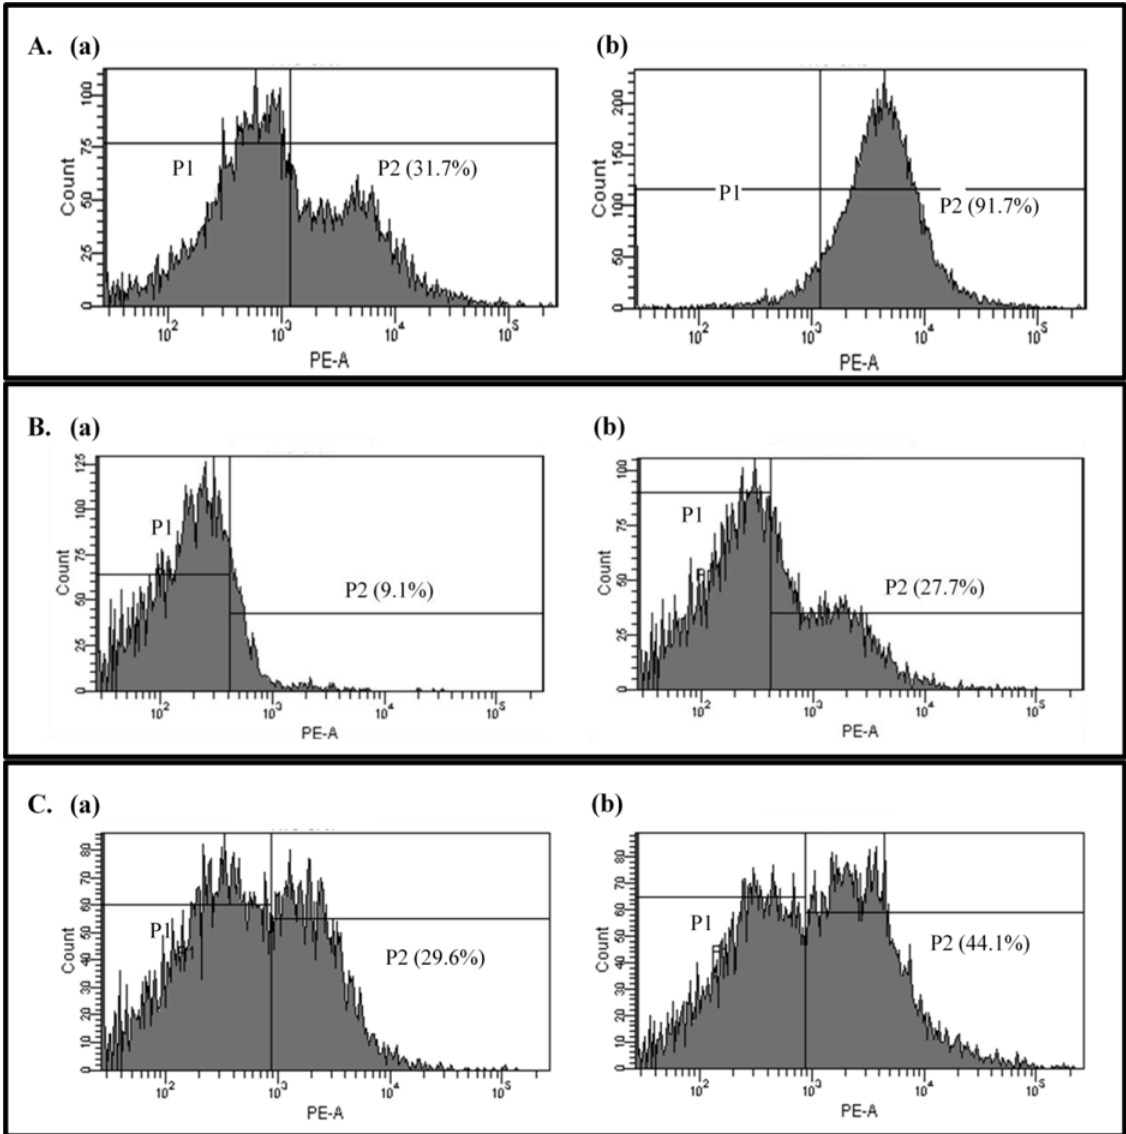
Fig 4. Propidium iodide uptake. Uptake of propidium iodide by untreated (a) or oleanolic acid-treated (2 × MIC) bacterial cells (b): Listeria monocytogenes (A), Enterococcus faecium (B), and Enterococcus faecalis (C). The area (P2) indicates the ratio of propidium iodide uptake cells.